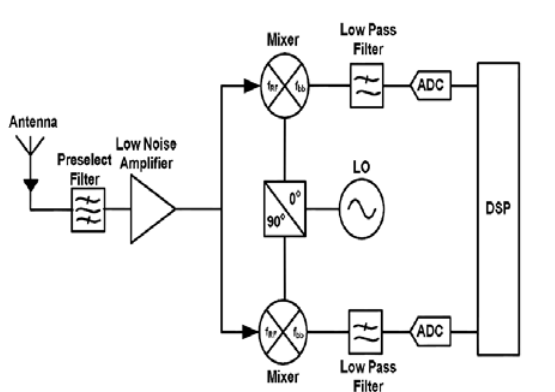
Figure 1: Classical Direct Conversion